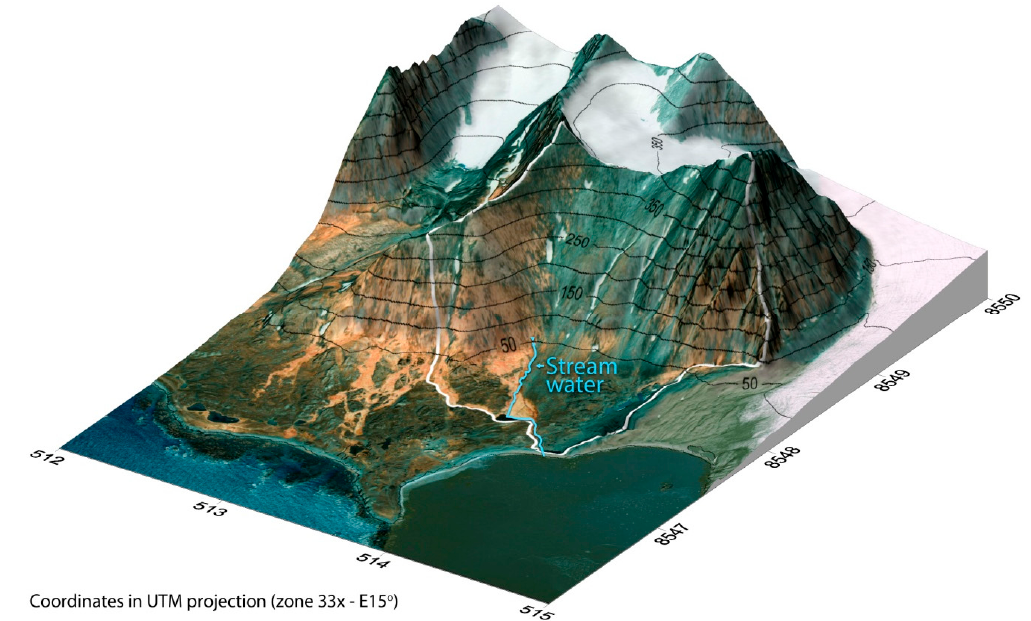
Figure 2. The sampling area location at Hornsund fjord, Spitsbergen.